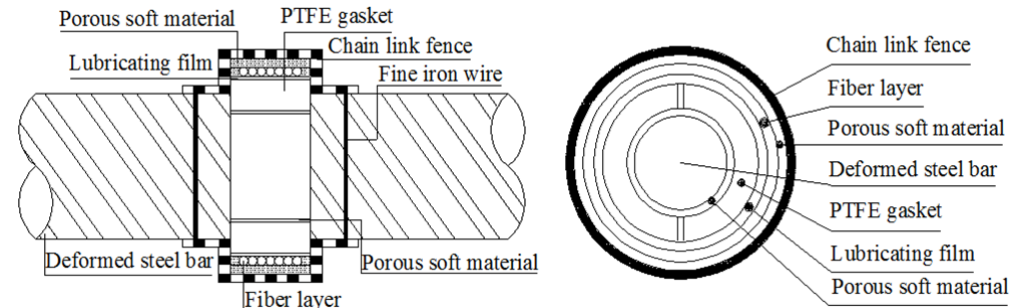
Figure 7. Packaging structure of